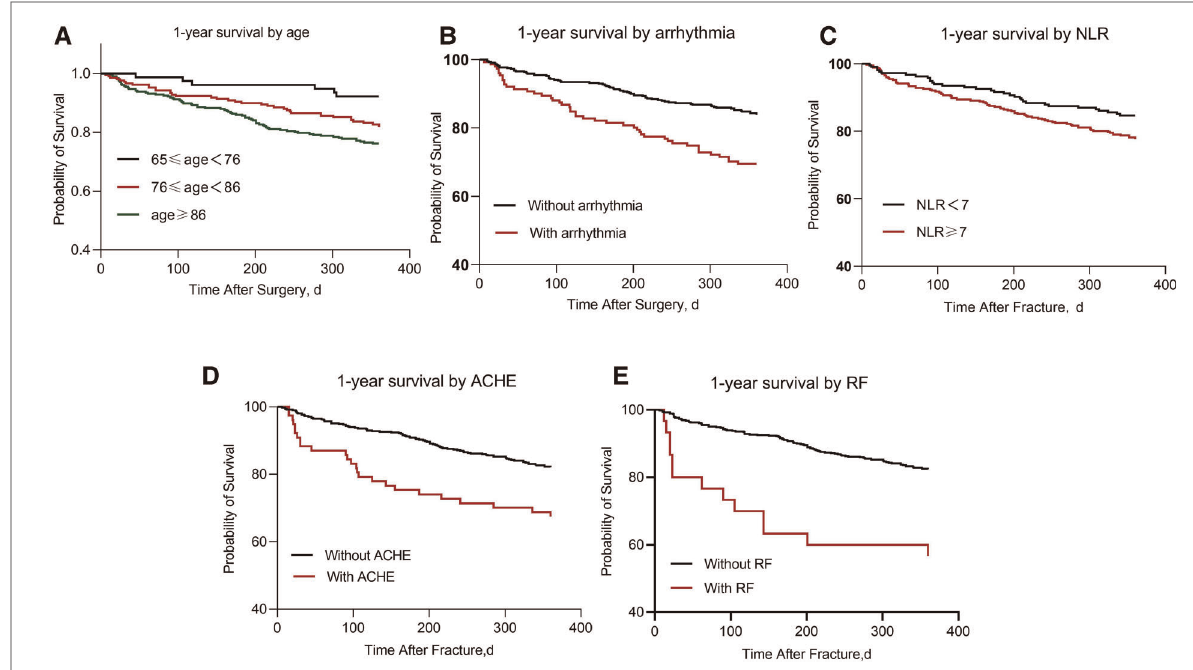
FIGURE 2 The graphs depict Kaplan-Meier estimated 1-year survival. ( A ) 1-year mortality by age ( P < 0.000); ( B ) 1-year mortality by arrhythmias ( P <0.000); ( C ) 1-year mortality by NLR level ( P =0.04); ( D ) 1-year mortality by acute cardiovascular events ( P <0.000); ( E ) 1-year mortality by respiratory failure ( P <0.000). ACHE, acute cardiovascular events; RF, respiratory failure.